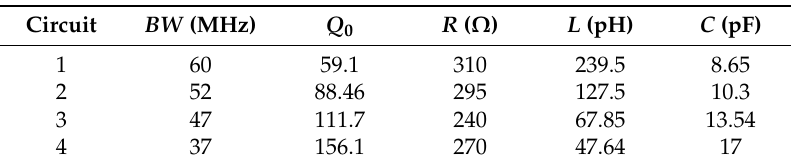
Table 3. Calculated lumped element values.